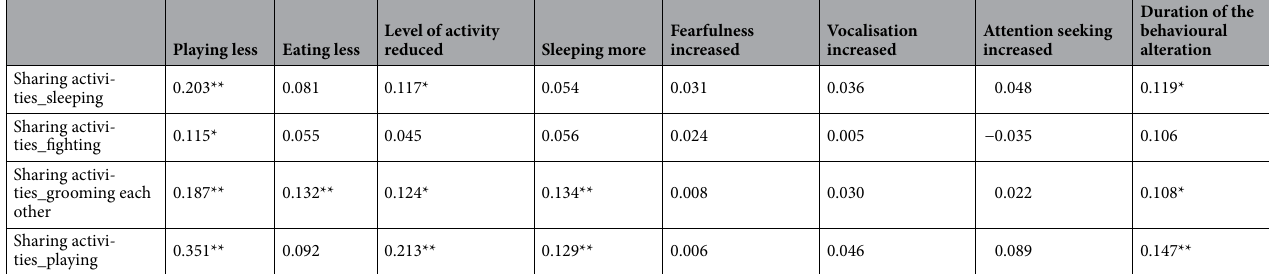
Table 4. Correlation between shared activities between the two dogs and behavioural change observed in the surviving dog after the death of the other dog. * p < 0.05; ** p < 0.01; *** p < 0.001.